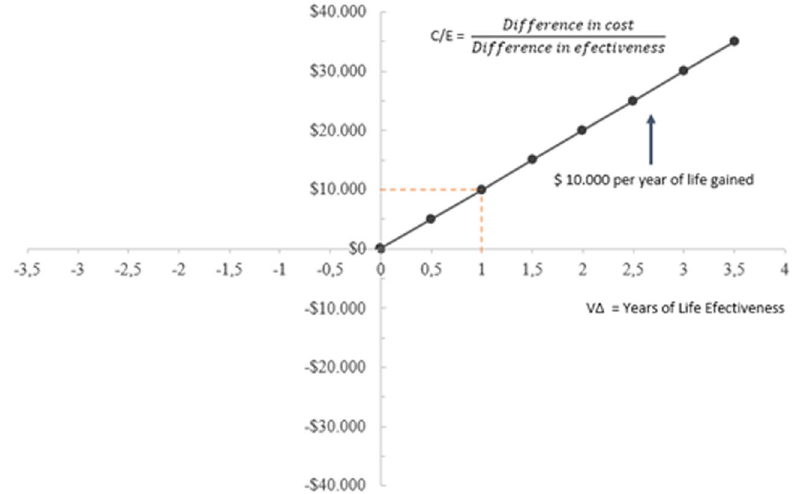
Fig. 1 Cost-effectiveness plane. Source: [12].